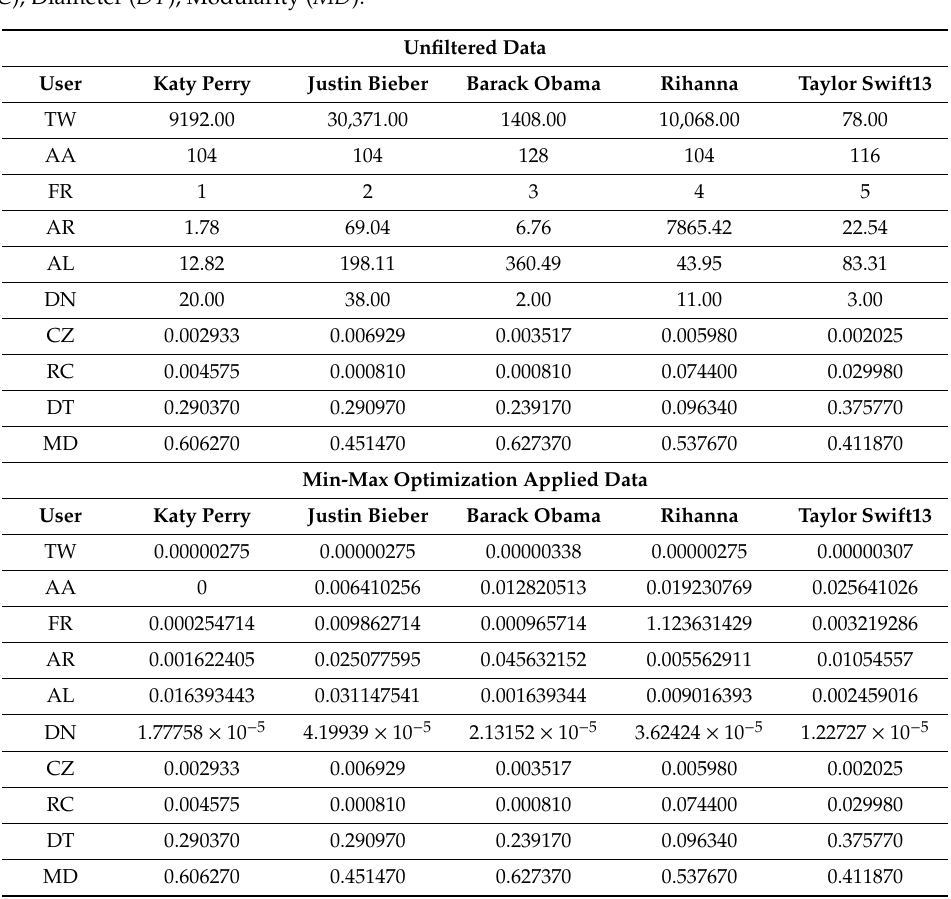
Table 4. Data set conversions with min-max optimization. Tweets ( TW ); Account Age ( AA ); Follower Rank (FR); Average Retweet ( AR ); Average Likes ( AL ); Density ( DN ); Centralization ( CZ ); Reciprocity ( RC ); Diameter ( DT ); Modularity ( MD